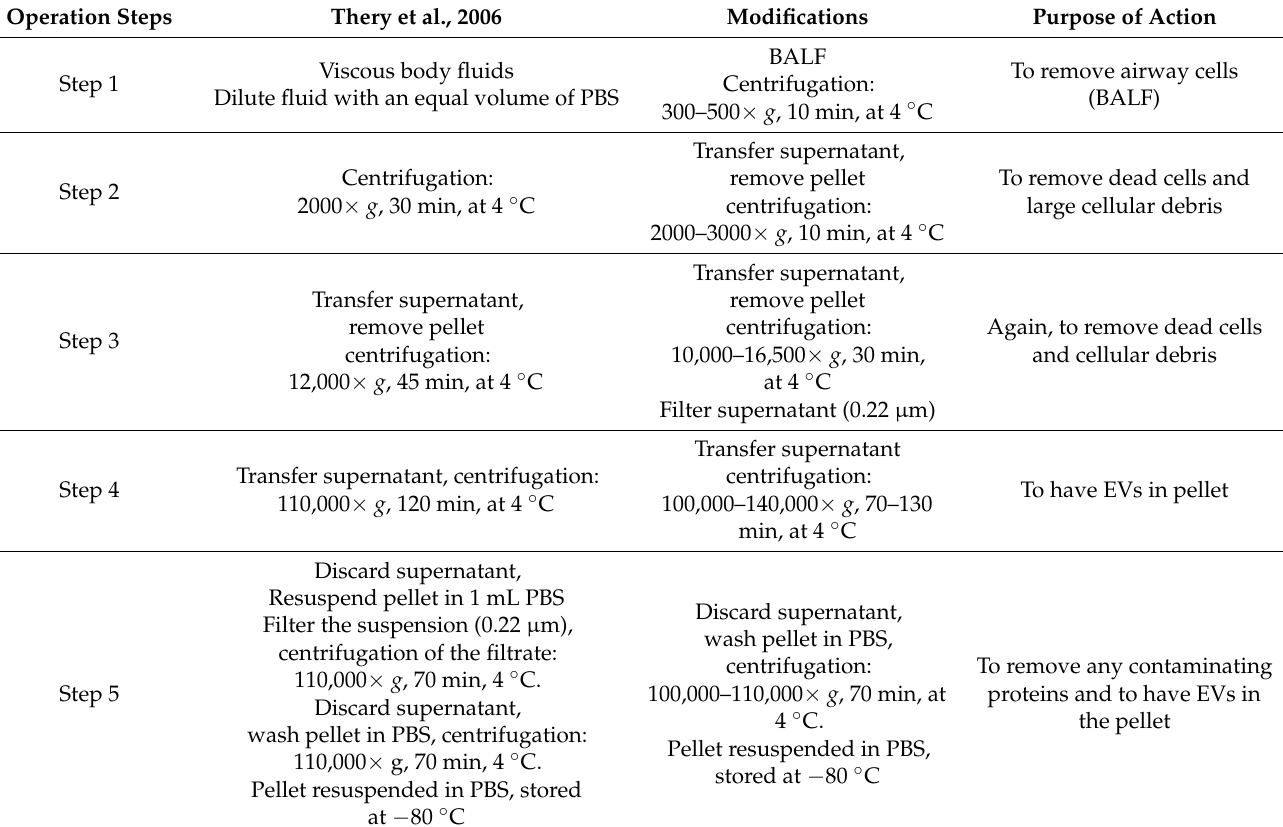
Table 1. Protocol for extracellular vesicle EV isolation from body fluids by Thery et al. [40] with adaptation to bronchoalveo- lar lavage fluid (BALF)